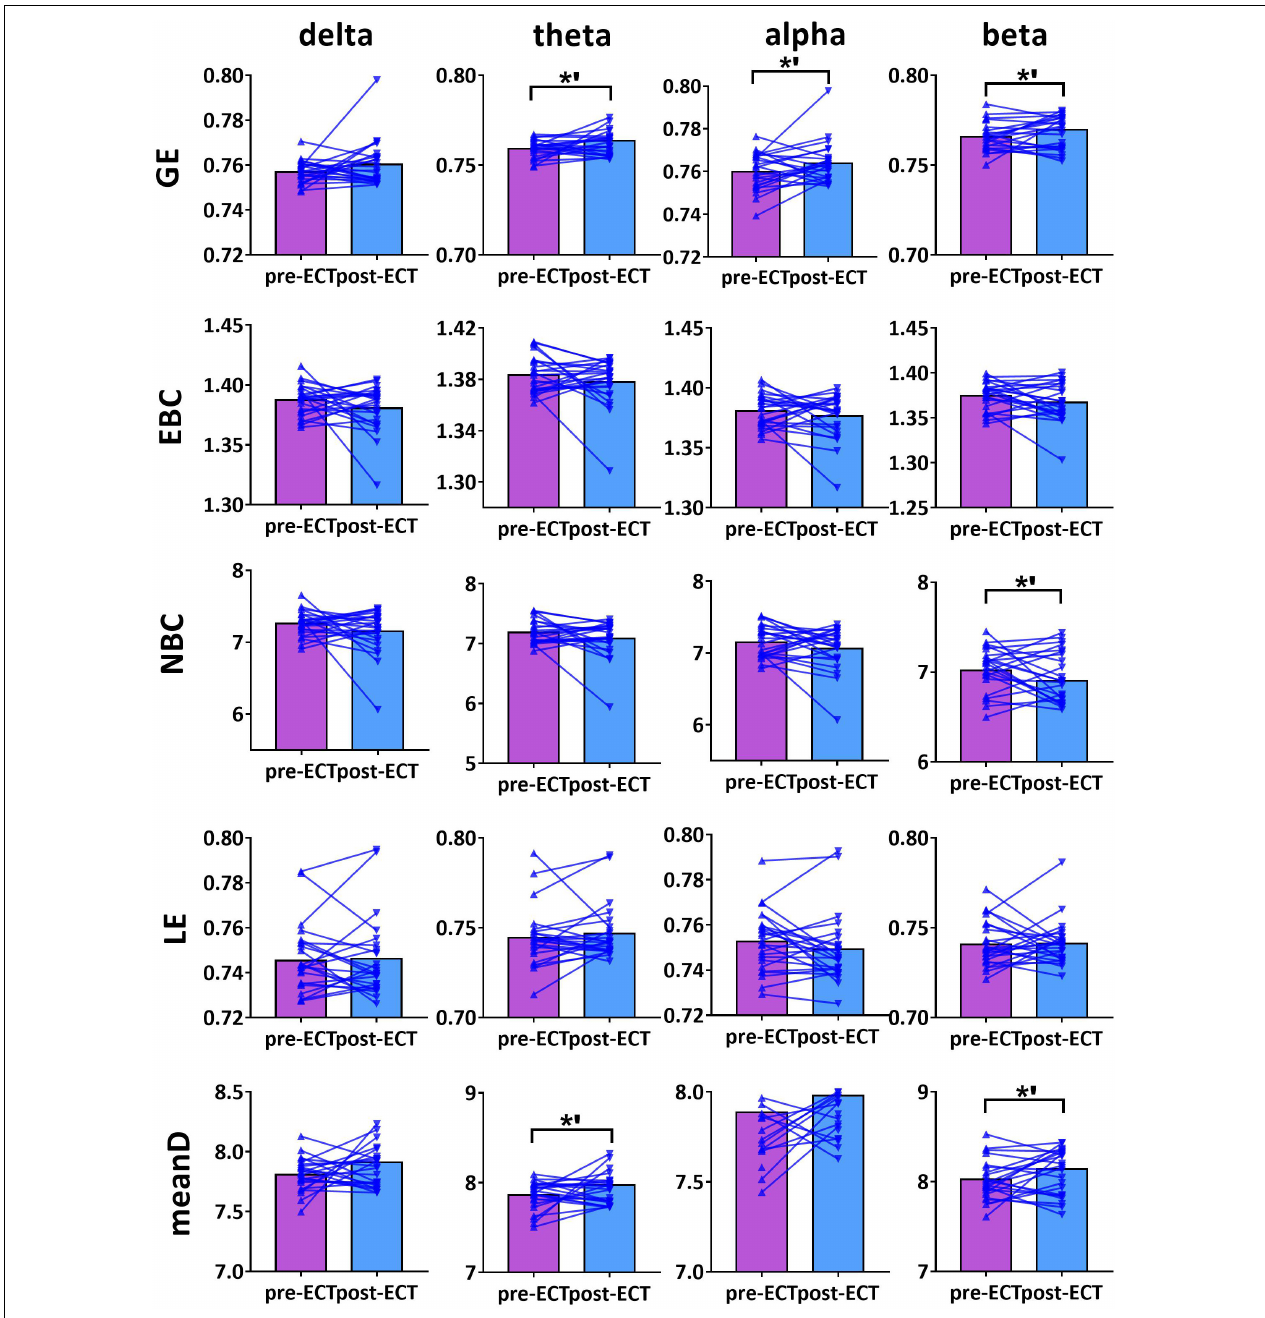
FIGURE 4 | Network metrics of pre- and post-ECT patients with MDD obtained by coupling method ICoh and binarization approach CST in delta, theta, alpha, and beta frequency bands. Other descriptions are as in Figure 3